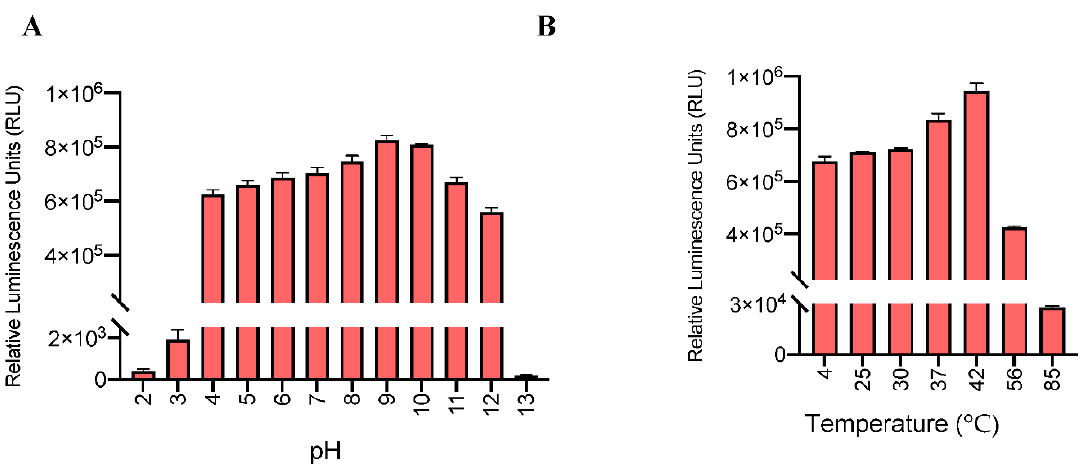
Figure 4. High stability of the HiBiT-RBD reporter system in supernatants at different temperatures and pH conditions. ( A ) Relative luminescence signal with LgBiT-substrate treatment of supernatants from low pH to high pH. ( B ) Relative luminescence signal with LgBiT-substrate treatment of supernatants from 4–85 °C.